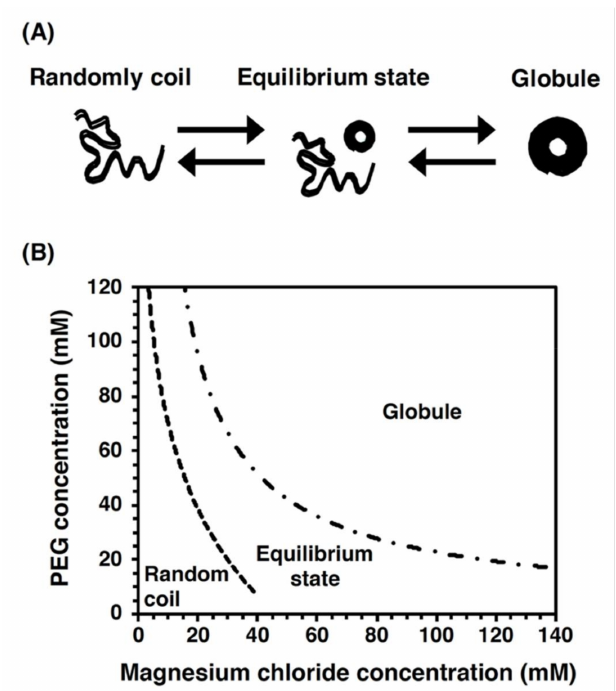
Figure 1. Outline of reversible phase transition between the randomly coiled state and globular state of the DNA molecules. ( A ) The phase transition of the physical form of DNA molecule using condensing agents. By adding condensing agents, the DNA molecule is transformed from a randomly coiled structure to a globular structure. By removing condensing agents, the globular DNA molecule reverts to the randomly coiled structure. The phase transition between the globular and the randomly coiled structures can be reversibly induced in a DNA molecule. ( B ) Relationship of PEG and salt concentrations with the phase transition between the globular and the randomly coiled structures. The dashed line denotes the phase transition between the randomly coiled structure and the equilibrium states, which involve the globular and the randomly coiled structures. The dot chain line denotes the phase transition between the globular structure and the equilibrium states, which involve the globular and the randomly coiled